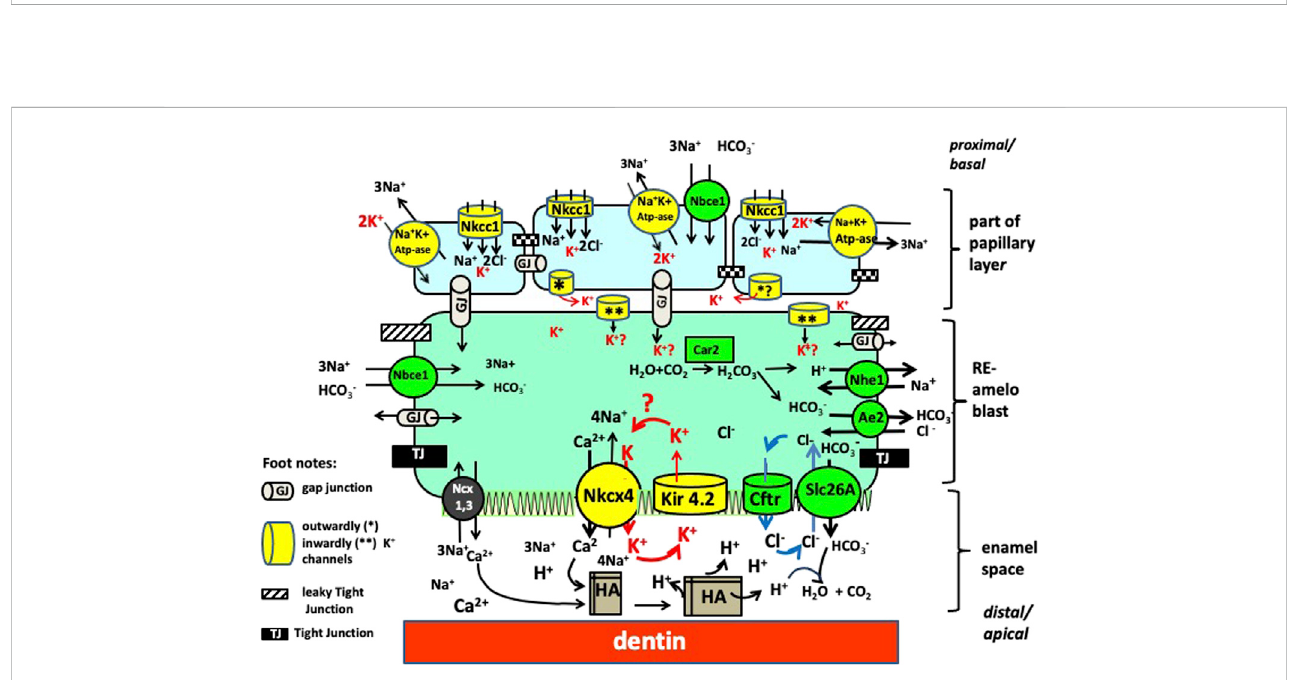
WorkingmodelforiontransportbyREameloblasts.Therearefourclustersoftransporterseachinvolvedinaspeci fi cfunction.Byrequiringthesameions to operate (Na + , K + and Cl − ) from the pool of ions these clusters are interdependent from each other. One cluster involves mineral transport to form crystals (NaPi2 and Nckx4 mediated transport of phosphate and calcium, respectively). A second cluster is for K + transport (in yellow) to obtain electrochemical gradients to drive ion transport (Nckx4, Kir 4.2, Na + K + ATpase, Nkcc1); Cluster 3 for pH and osmoregulation (in green, includes Cftr, Ae2, Nhe1 and members of the Slc26a family (SIc26a-a3-a4, a6, a7; Nhe1 and Car2). Cluster 4 for paracellular and intracellular transport tight junctions (black) and gap junctions (grey